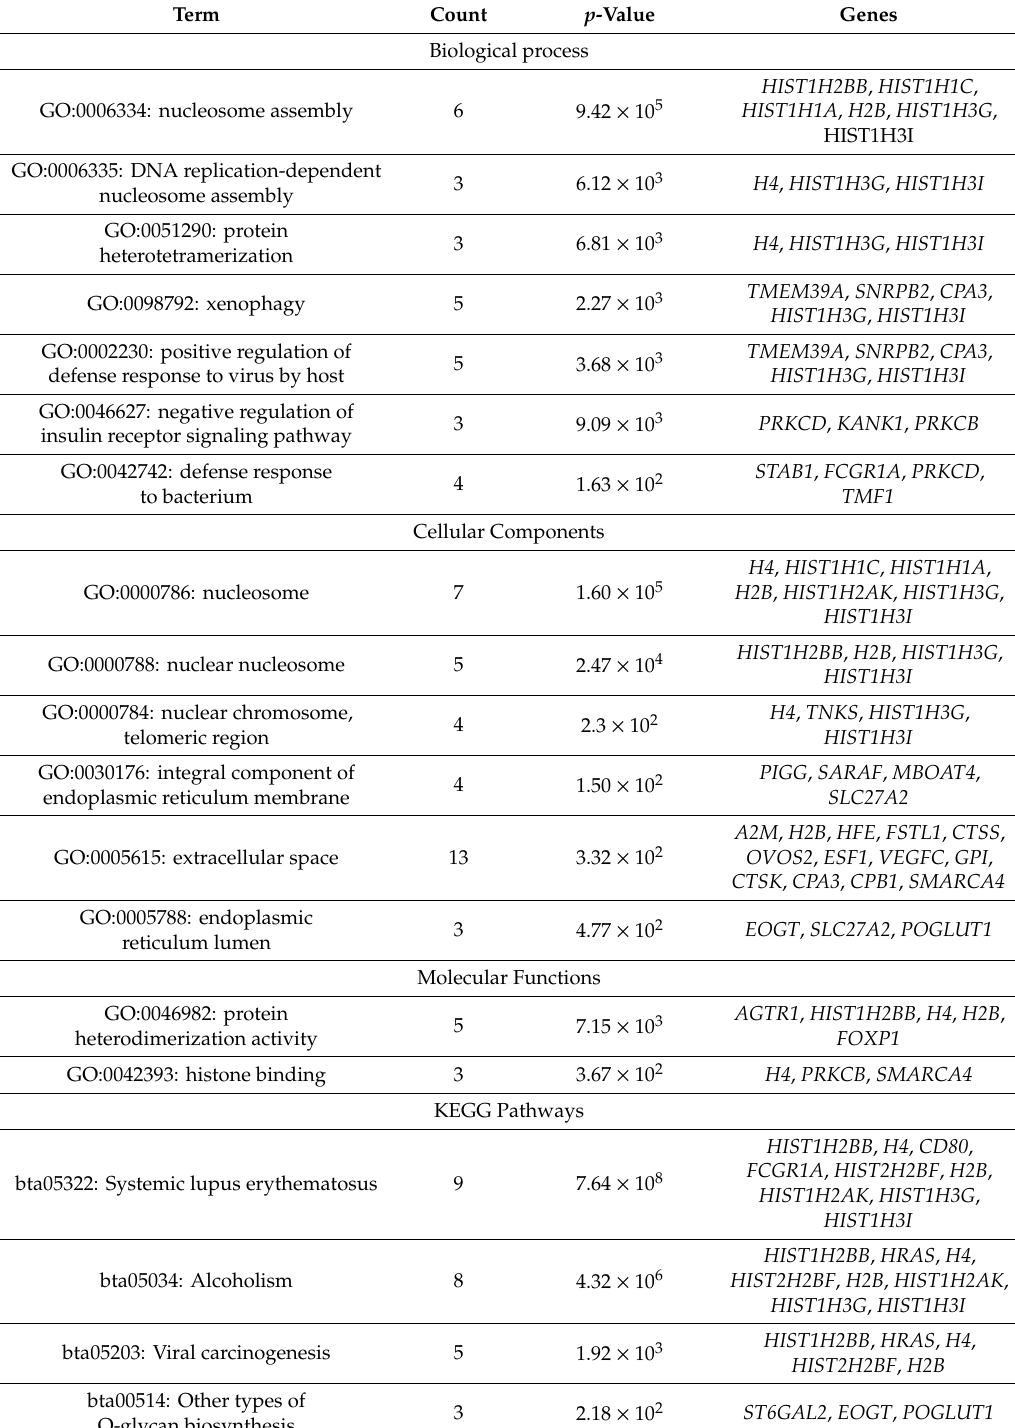
Table 2. Results of the gene annotation: DAVID GO and pathway analysis (KEGG). Term Count p -Value Genes Biological